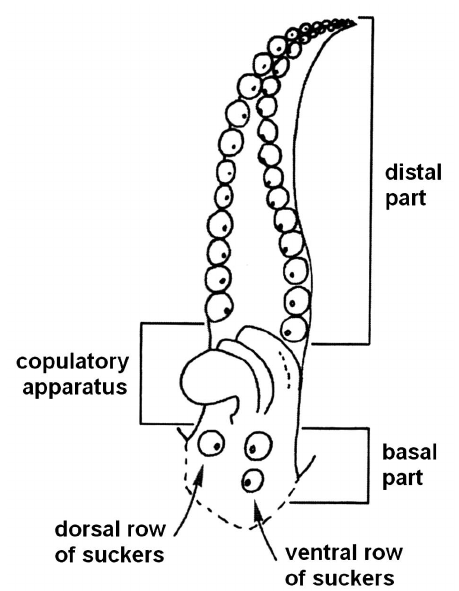
Fig . 1. – Schematic rendering of the general Sepiola hectocotylus (the basic type of the Sepiola atlantica group is depicted here) (after Bello